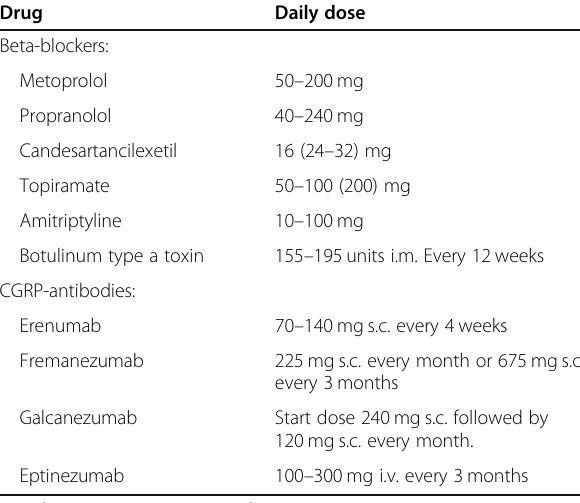
Table 9 Preventive medication against chronic migraine with recommended